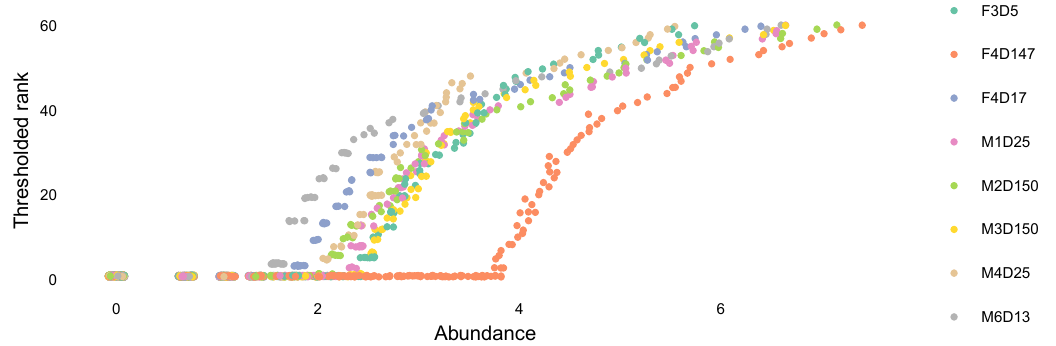
Figure 15. The association between abundance and rank, for a few randomly selected samples. The numbers of the y -axis are those supplied to